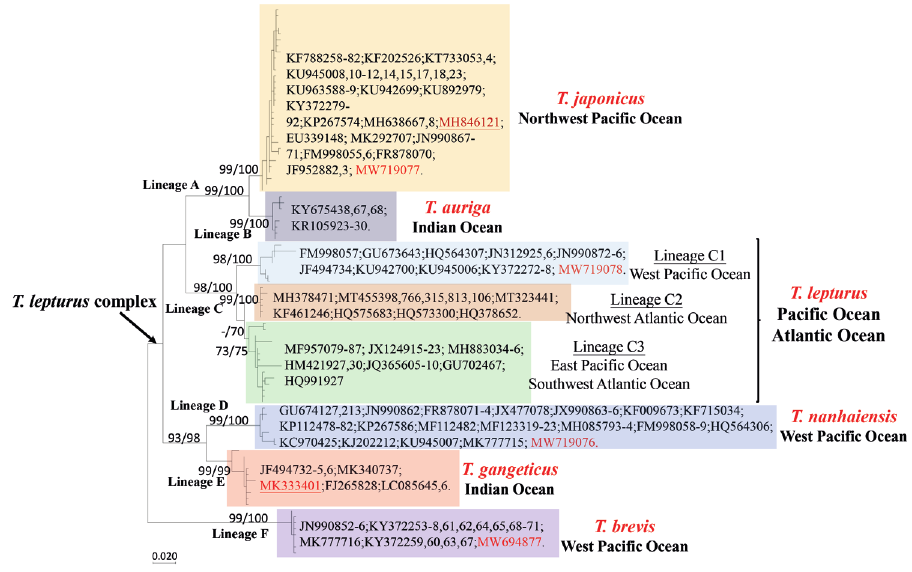
Figure 4. The maximum-likelihood (ML) tree of six Trichiurus species in the world based on the COI gene. The numbers at the nodes are bootstrap values of the ML and NJ (neighbor-joining)